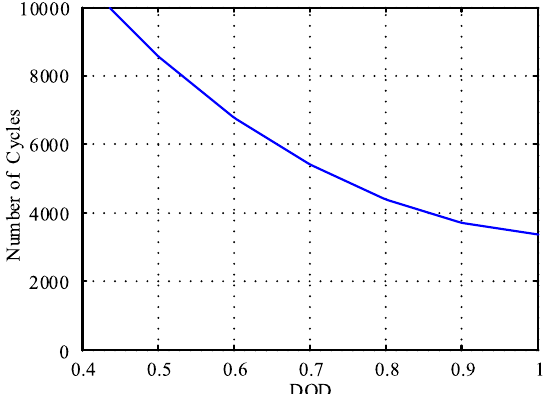
Fig. 2 The relationship between DOD and cycle life